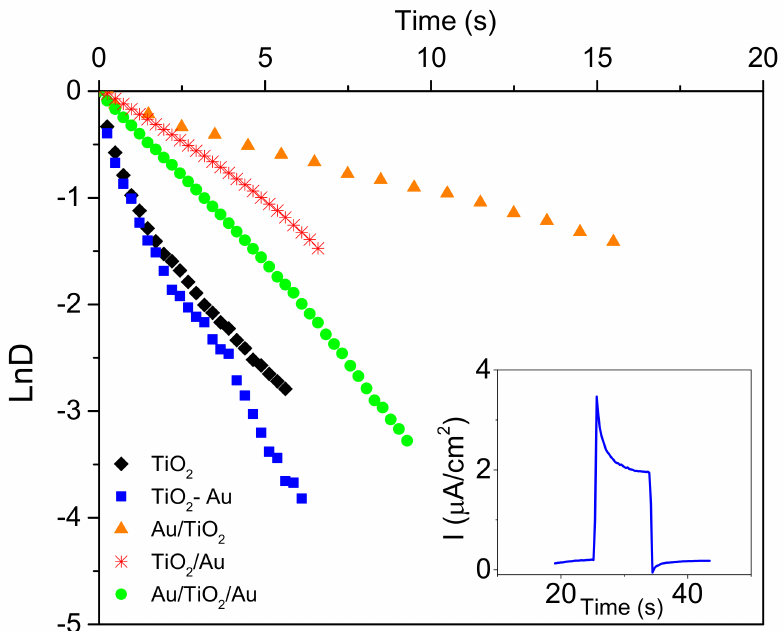
Figure 7. Example of the kinetics of the photocurrent, at TiO 2 –Au sample, when the light is sudden switched on and